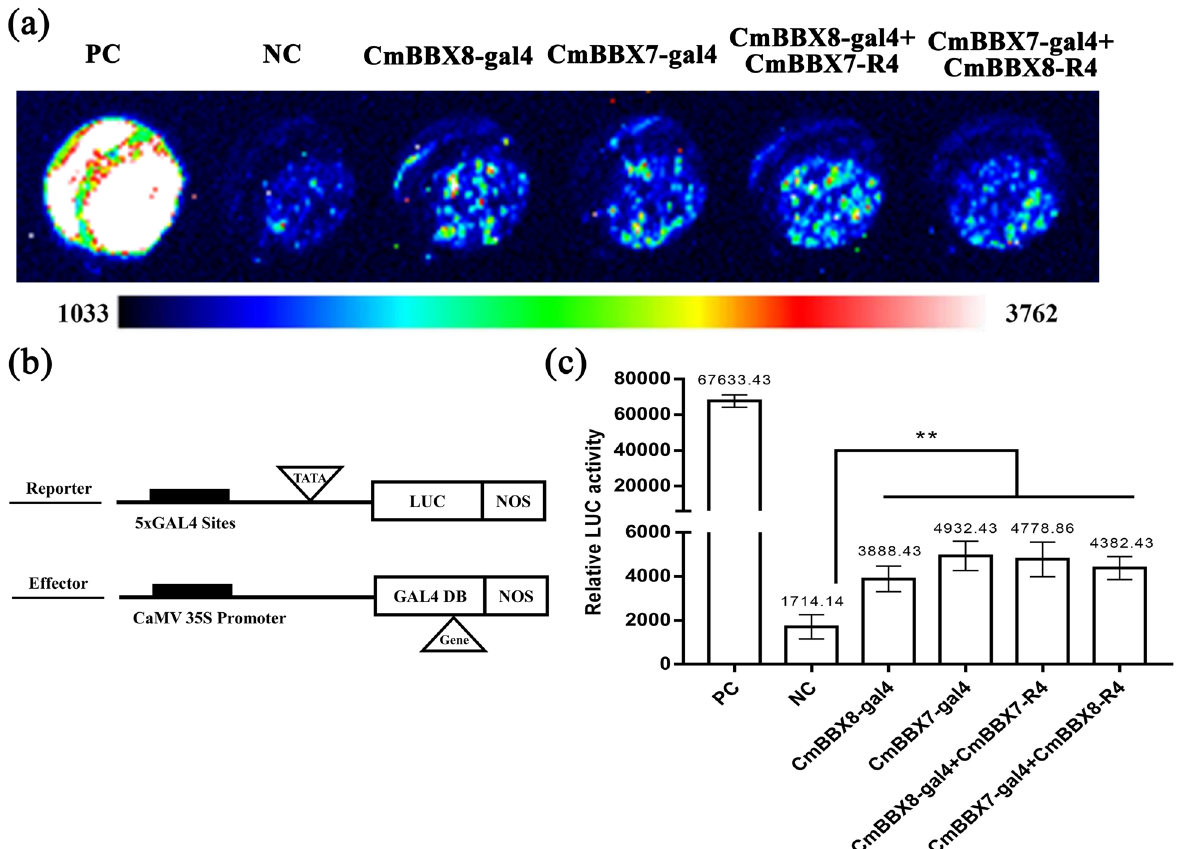
Fig. 7 CmBBX7 and CmBBX8 do not mutually affect each other’s activity. Fluorescence images: from blue to red, the fluorescence value increases gradually. PC: positive control (AtARF5); NC: negative control (empty vector). b Vector construction diagrams for the reporter and effector constructs used in the transcription activity assay. The reporter construct contains five copies in tandem of the GAL4-binding sites upstream of the promoter (TATA), the firefly gene for luciferase, and Nos. The effector constructs contain the GAL4 DNA-binding domain (GAL4 DB) between the CaMV 35S promoter and Nos. c Relative LUC activity. Error bars indicate the standard deviations for six biological replicates. Significant differences are indicated with asterisks (** p < 0.01, ANOVA with Tukey’s post-hoc